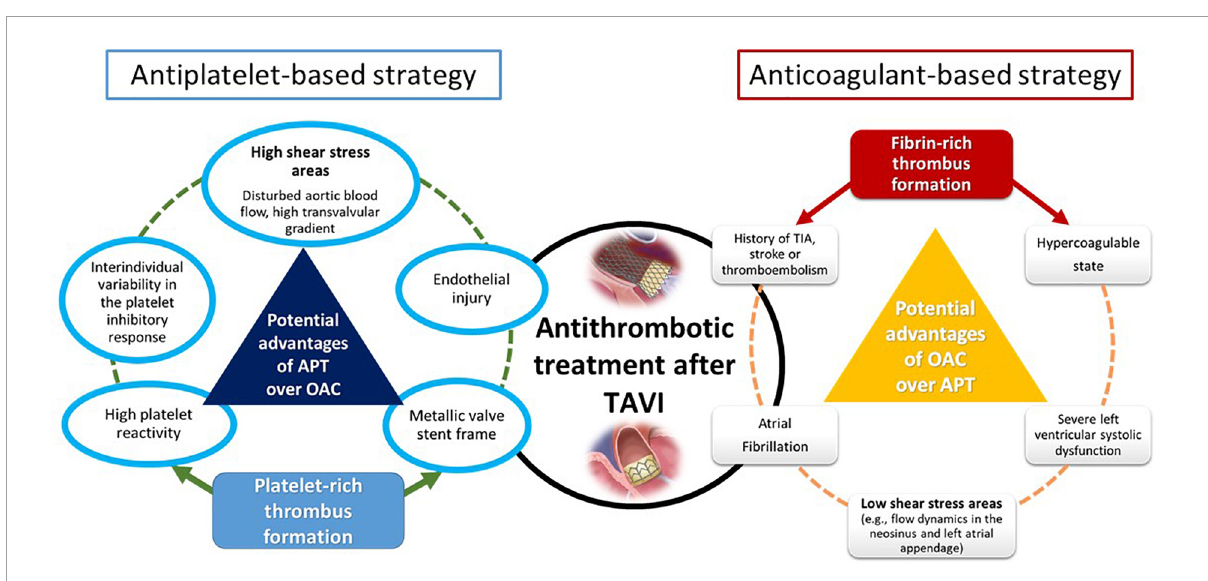
on the intensity of the neurological and imaging tests